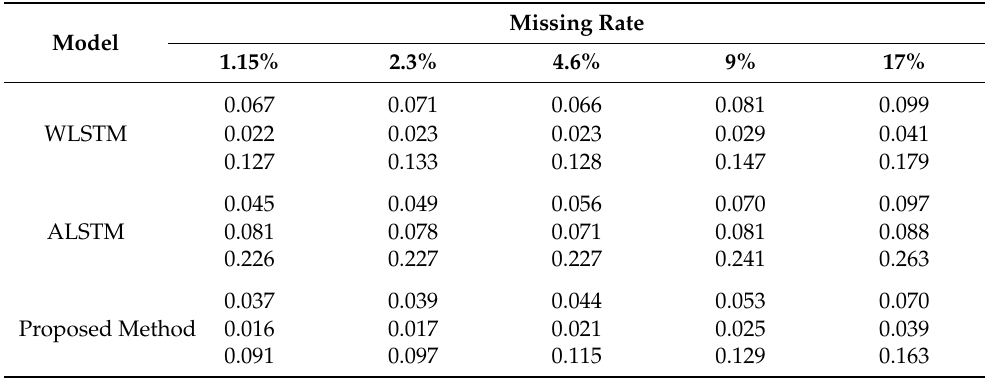
Table 5. Quantitative comparison with different missing rates. (The top, middle, and bottom represent MAE, MSE, and RMSE values,